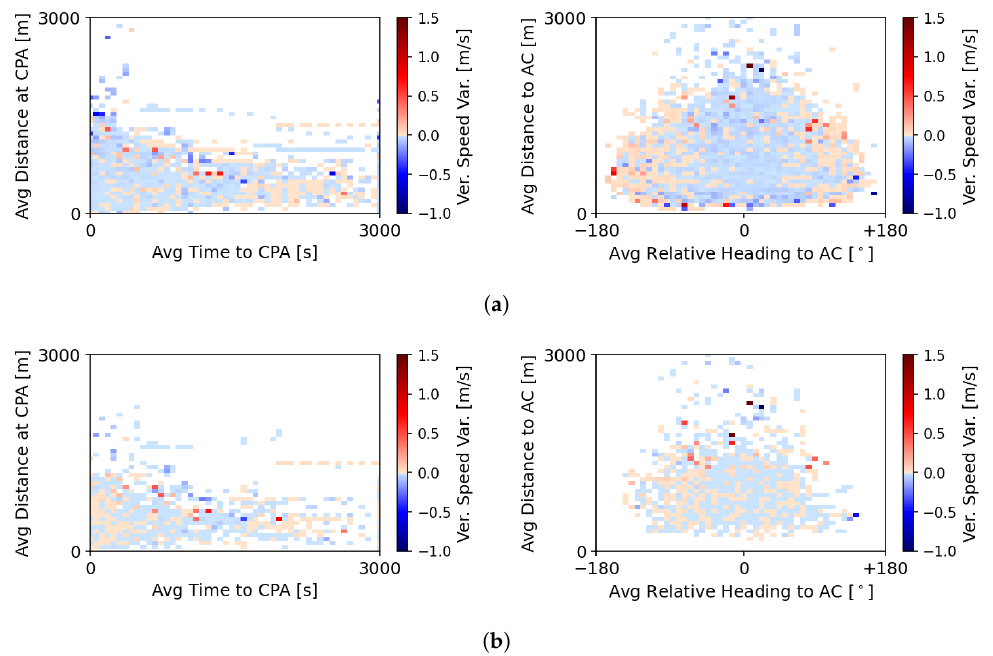
Figure 10. Vertical speed variation performed by ( a ) the baseline MVP and ( b ) and the hybrid RL + MVP methods. ( a ) Vertical speed variation performed by the baseline MVP method (look-ahead time = 300 s. Heading, speed, and altitude variations were always active). ( b ) Vertical speed variation performed by the hybrid RL + MVP method.